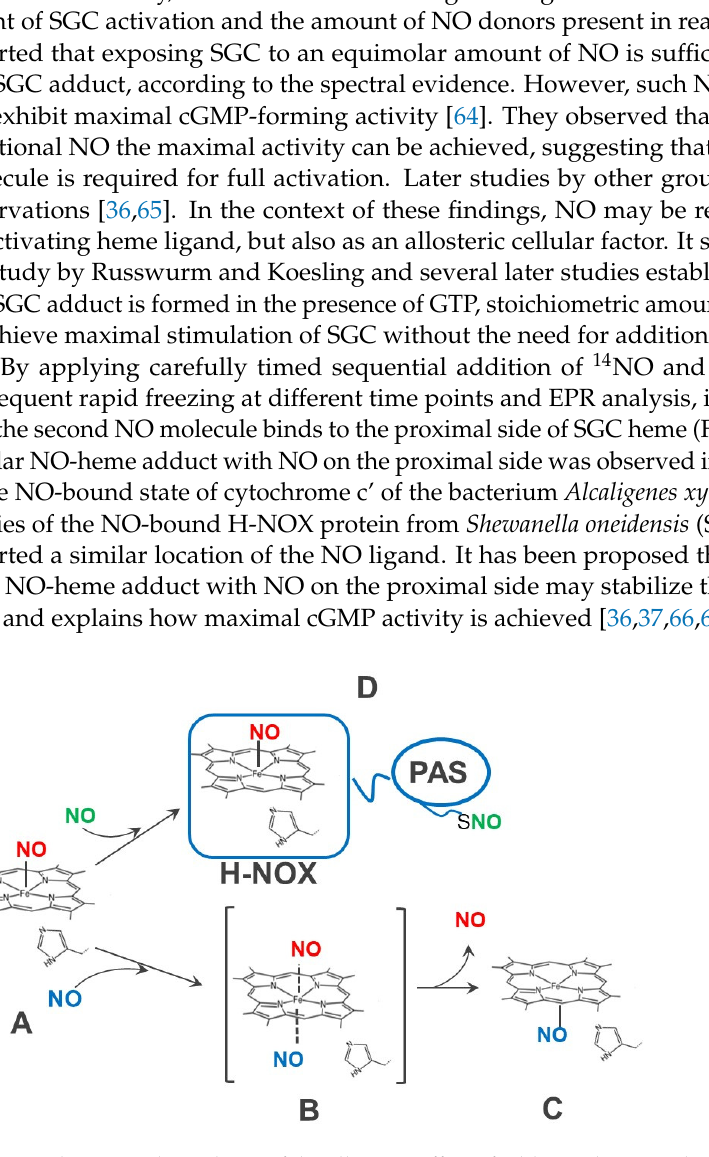
Figure 2. Alternative hypothesis of the allosteric effect of additional NO. In the presence of NO excess, the five-coordinate NO-heme adduct (state A ) may bind a second NO to form a transient ternary complex (state B ), which rapidly loses the distal NO and converts into a five-coordinate NO-heme adduct with NO bound on the proximal side of heme (state C). Alternatively, the allosteric effect of additional NO is explained by S-nitrosylation of an unspecified cysteine residue resulting in a full stimulation cGMP-forming activity (state D).